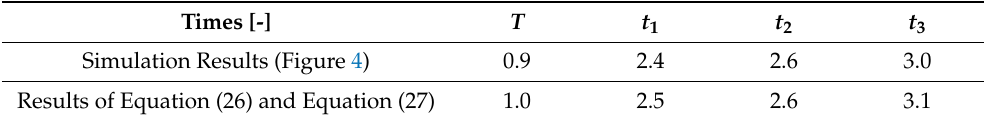
Table 4. Comparison between the simulation and analytical results for the case of the three bubbles. Times [-] T t 1 t 2